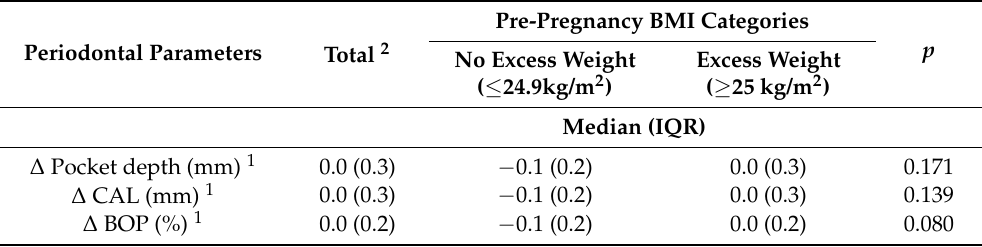
Table 2. Change in periodontal health measures (delta) 1 among pregnant women with periodontitis according to pre-pregnancy BMI categories.